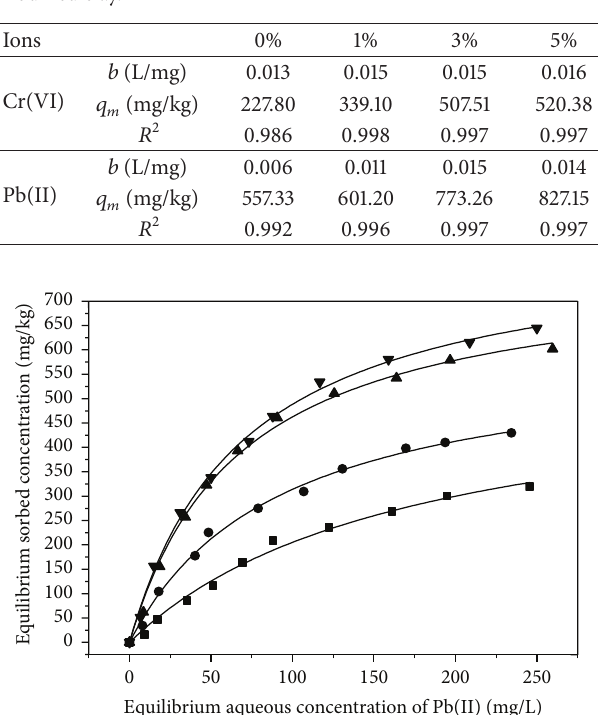
Table 5: The isotherm parameter for Cr(VI) and Pb(II) with modified clay.